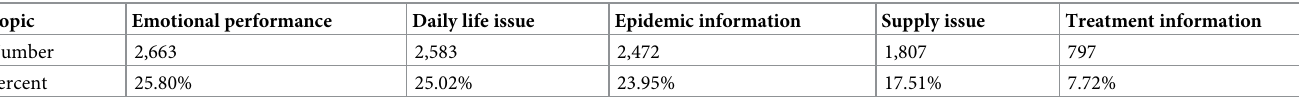
Table 2. Statistics of Weibo on different topics.